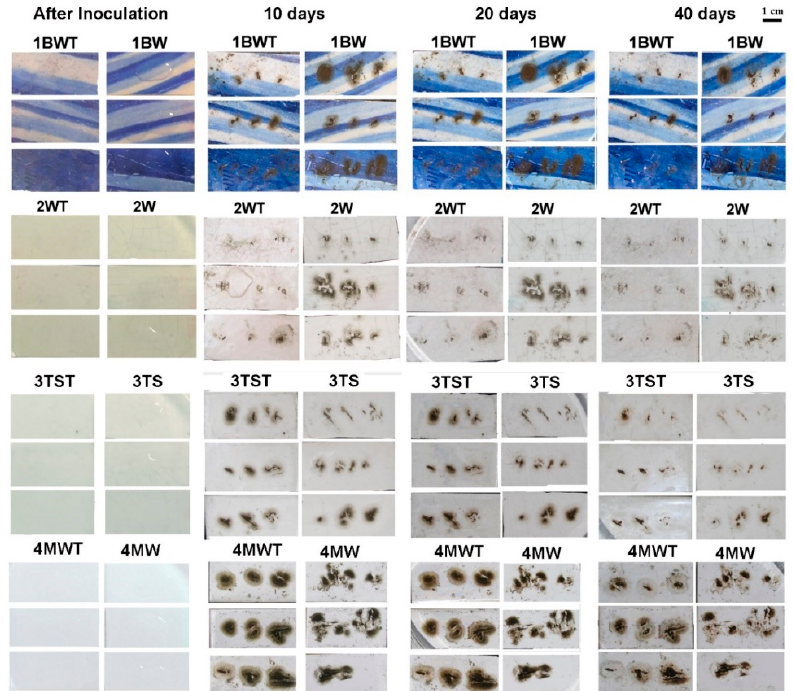
Figure 5. Photographic documentation made during the experiment of the fungal growth on glaze tile samples 1BW (non-treated); 1BWT (TiO 2 -treated); 2W (non-treated); 2WT (TiO 2 -treated); 3TS (non-treated); 3TST (TiO 2 -treated); 4MW (non-treated) and 4MWT (TiO 2 -treated) at four different stages: after inoculation, after 10 days incubation, after 20 days incubation and after 40 days incubation. Scale bar: 1 cm.